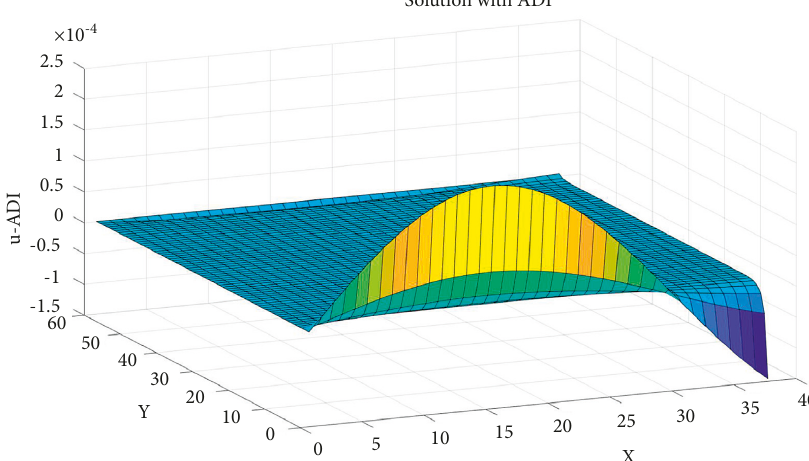
Figure 4: Approximate results of ADI at k � 0 . 001 and grid size � 25 × 25.